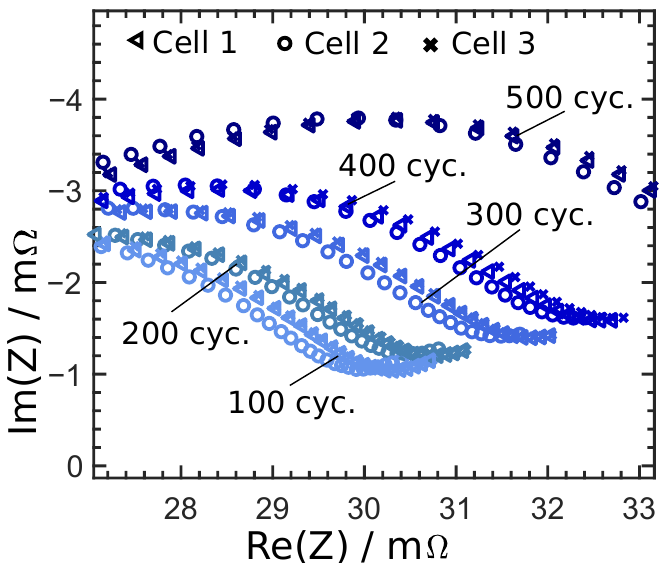
Figure 2. Nyquist plot for 3 Samsung INR18650-15L1 cells after 100, 200, 300, 400, and 500